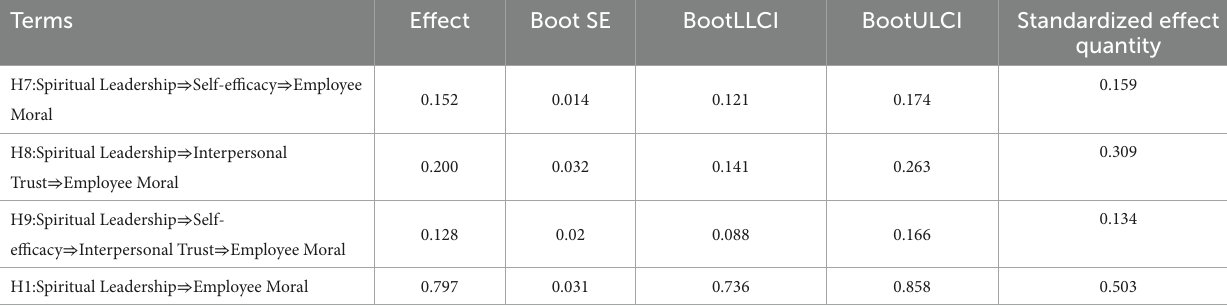
TABLE 5 Analysis of intermediary effect between spiritual leadership and employee morale. Terms Standardized effect